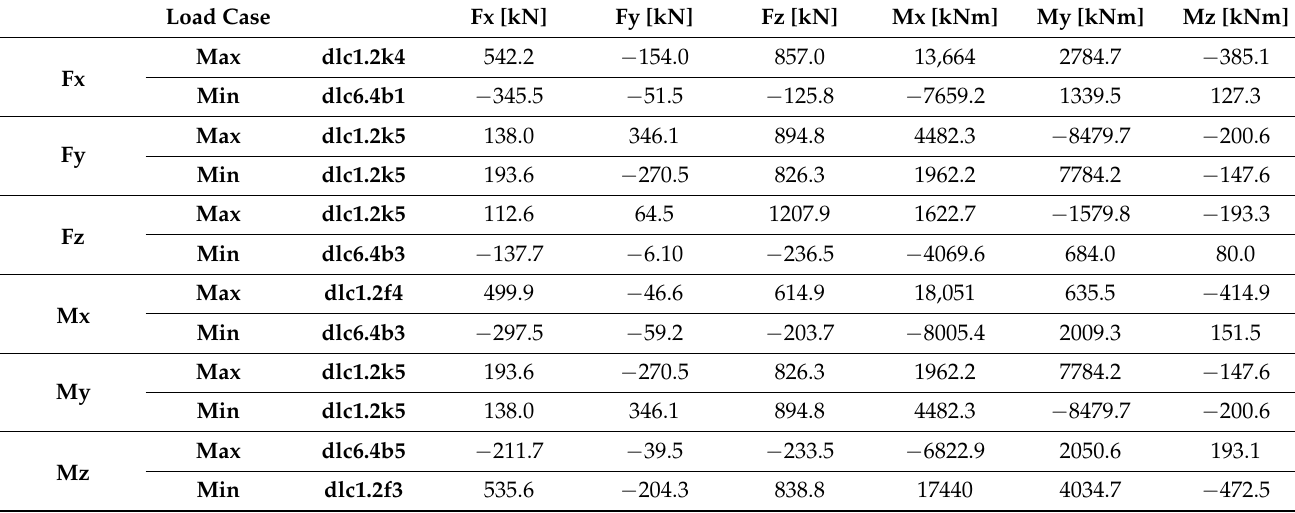
Table 4. Ultimate loads at the blade root [14].